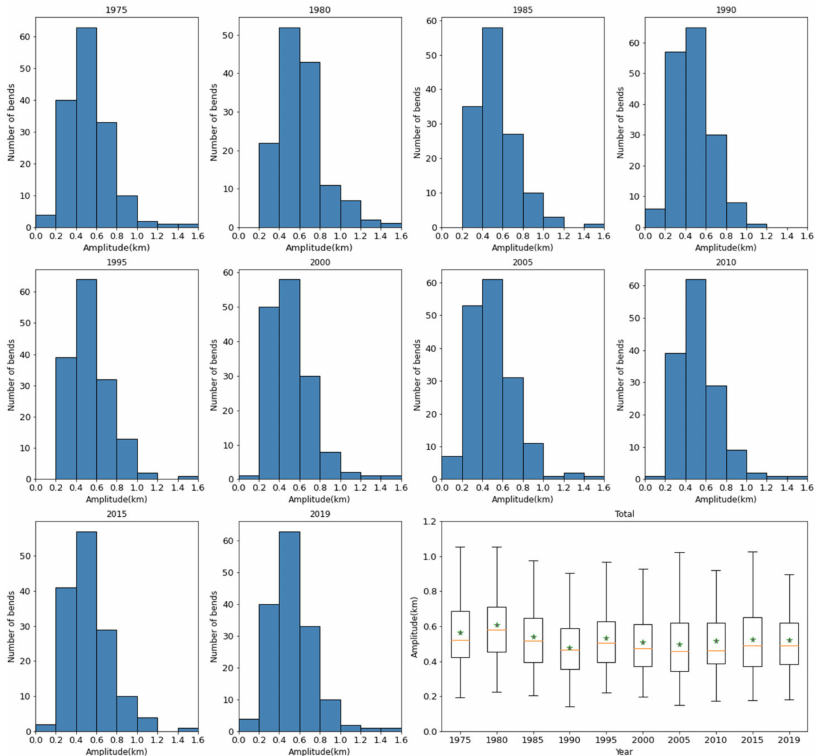
Figure 6. The measured meander direction angle in 1975, 1980, 1985, 1990, 1995, 2000, 2005, 2010, 2015, and